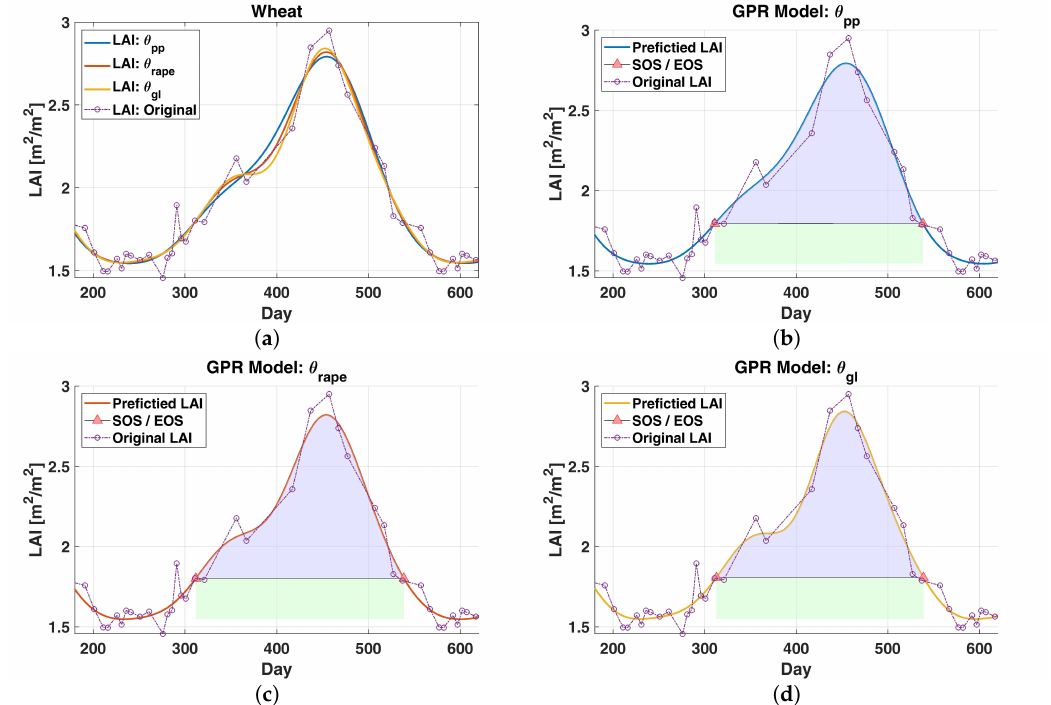
Figure 2. Modeling LAI time series of wheat by using different GPR parametrizations ( θ pp , θ Rape , θ gl ) (Figure 2a) and automatic identification of some seasonal patterns (Figure 2b, 2c and 2d). The green and blue colors represent the area under the curve between SOS and EOS. For reasons of clarity the associated GPR uncertainties are not displayed. Counting of days starts from 1 January